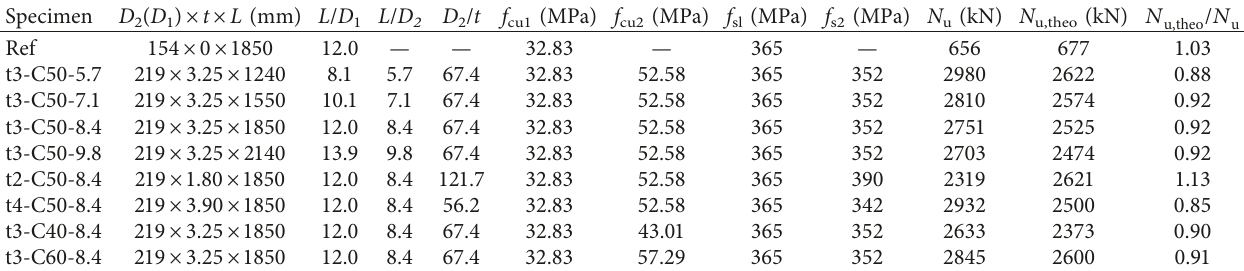
Table 1: Specimen